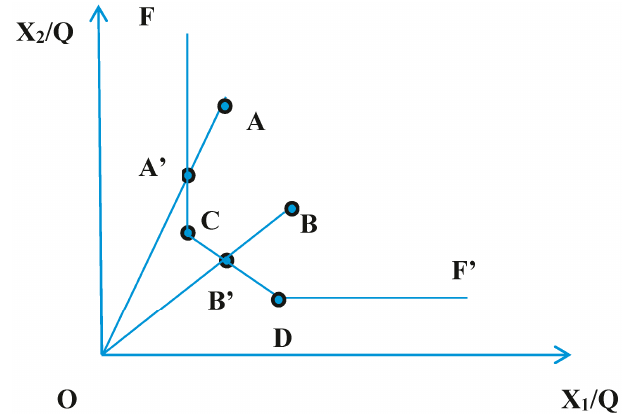
Figure 1. Representation of input slacks: case of two inputs, X 1 and X 2 . Source: the authors, adapted from Coelli et al. [32].